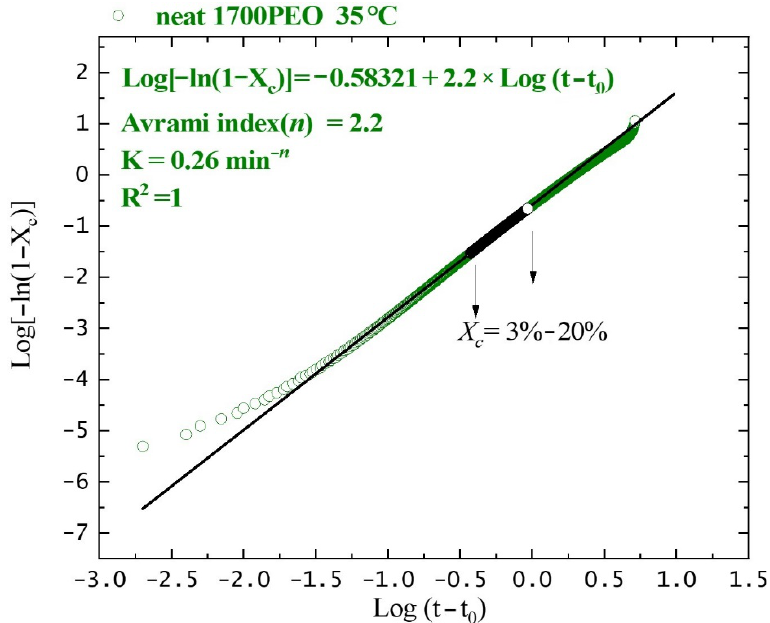
Figure 5. Isothermal crystallization behavior explored by DSC. Plots of relative crystallinity vs. crystallization time for neat 1700PEO at 35 °C. The solid lines are the fittings according to Equation (3).